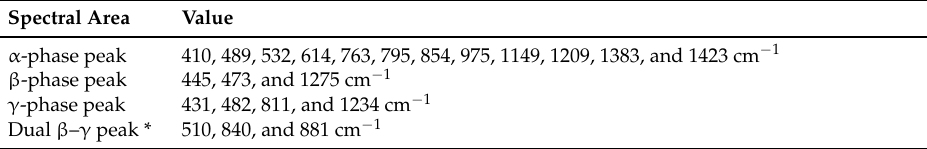
Table 4. List of the most commonly identified values for α -, β -, and γ -phases in FTIR absorption spectrum. The last line also lists the values of the so-called dual peaks, as they are denoted by some authors